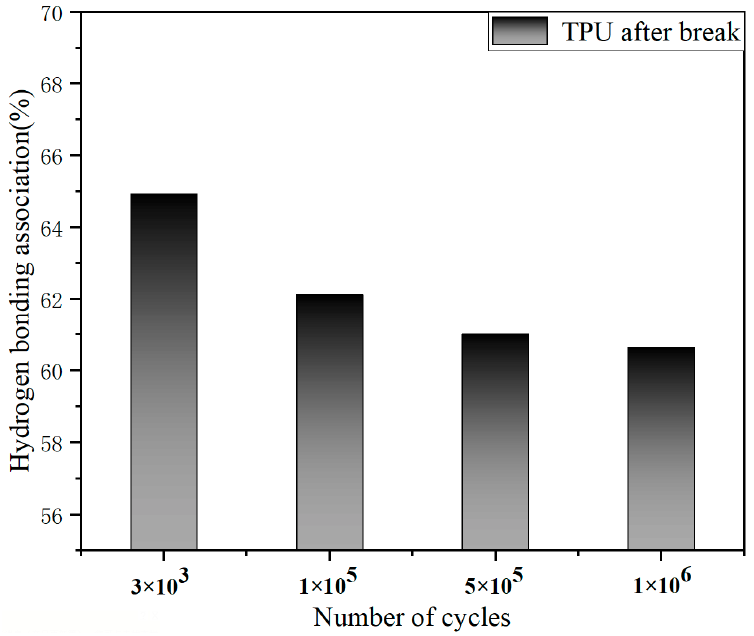
Figure 9. The variation of hydrogen bonding association (HBA) of TPU samples after fatigue.